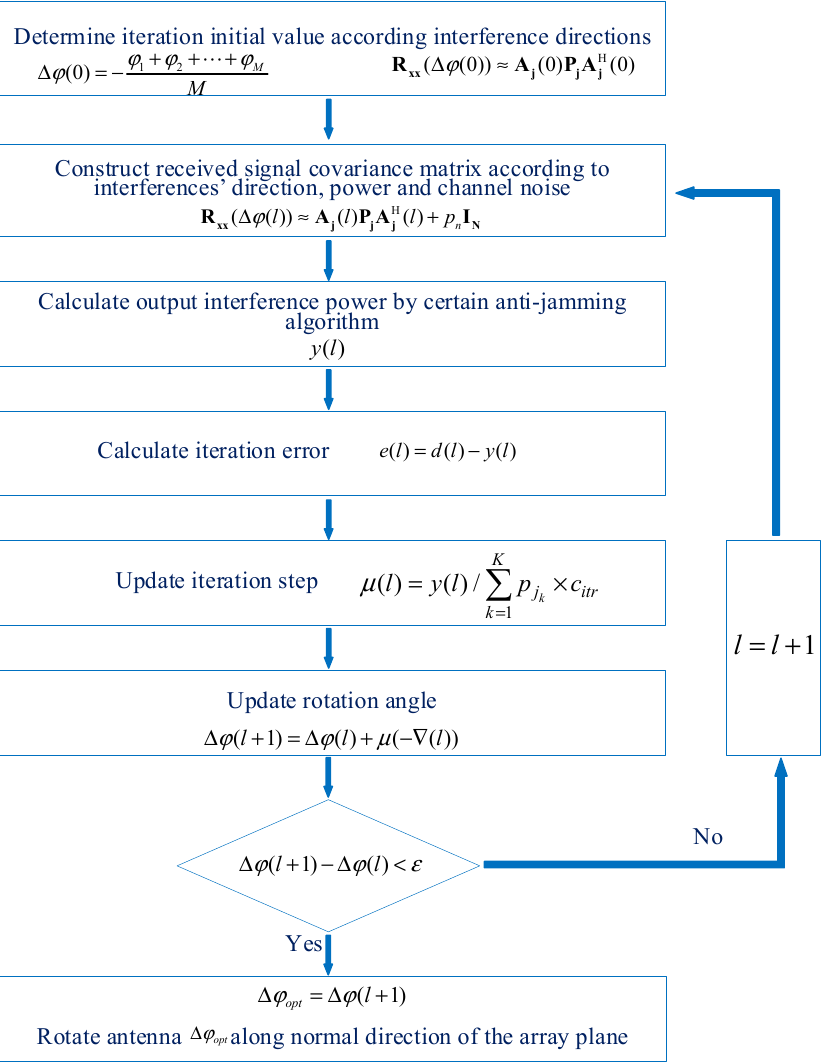
Figure 5. Iteration algorithm flow chart.